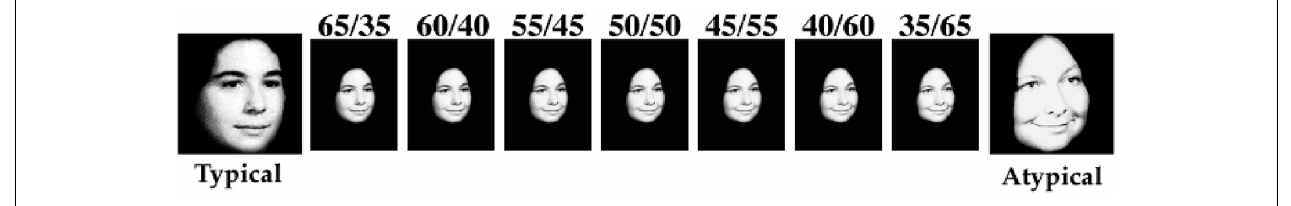
FIGURE 3 | Example of the continuum of morph faces produced by image averaging a typical and atypical face pair. Morph faces in the continuum were produced in 5% intervals ranging from 35% contribution from the atypical (typical) parent to